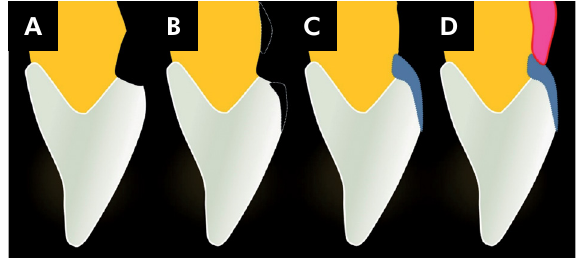
Figure 8. Schematic view of how to manage a B+ tooth surface. Baseline view of the defect (a). The coronal and apical borders of the non-carious cervical lesion (NCCL) should be managed. The two black zones delimited by white dotted lines represent the extent of the structure that should be removed to provide a proper and harmonious emergence profile (coronal zone) and to smooth the root surface to receive the graft/flap (apical zone) (b). After completion of the restorative procedure. The blue area represents the partial NCCL restoration placed apically 1 mm beyond the estimated cementoenamel junction (CEJ) level (CEJ+1 mm), correcting the emergence profile. Note that the root surface is smooth (c). Final representation after root coverage